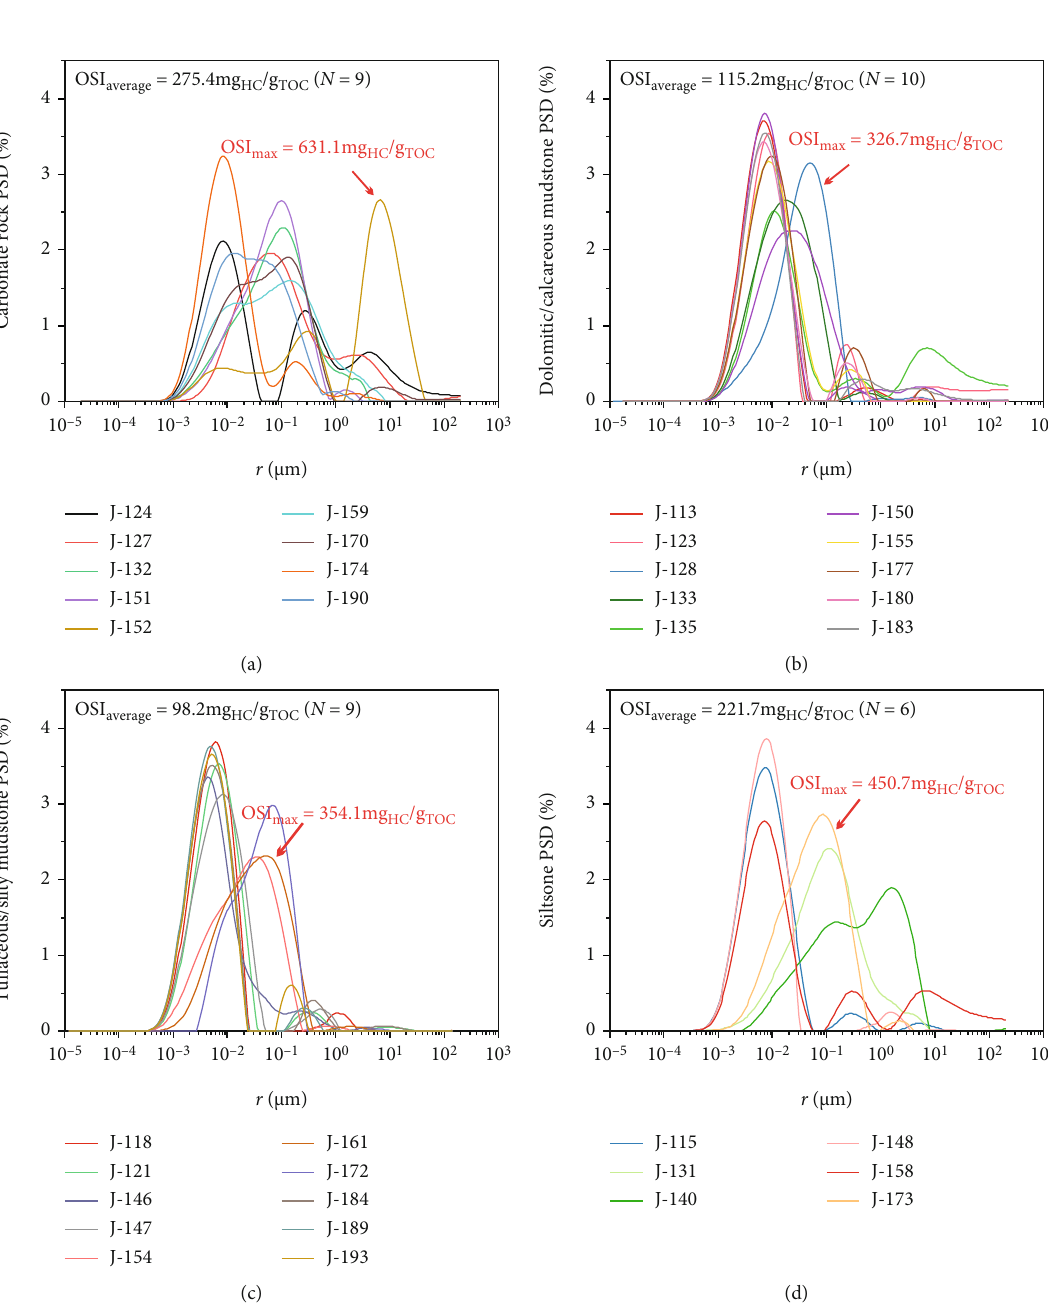
Figure 11: NMR T spectra for di ff erent lithofacies in the Lucaogou Formation, Jimusar Sag. Pore size distributions in (a) carbonate rocks, 2 (b) dolomitic/calcareous mudstones, (c) tu ff aceous/silty mudstones, and (d)